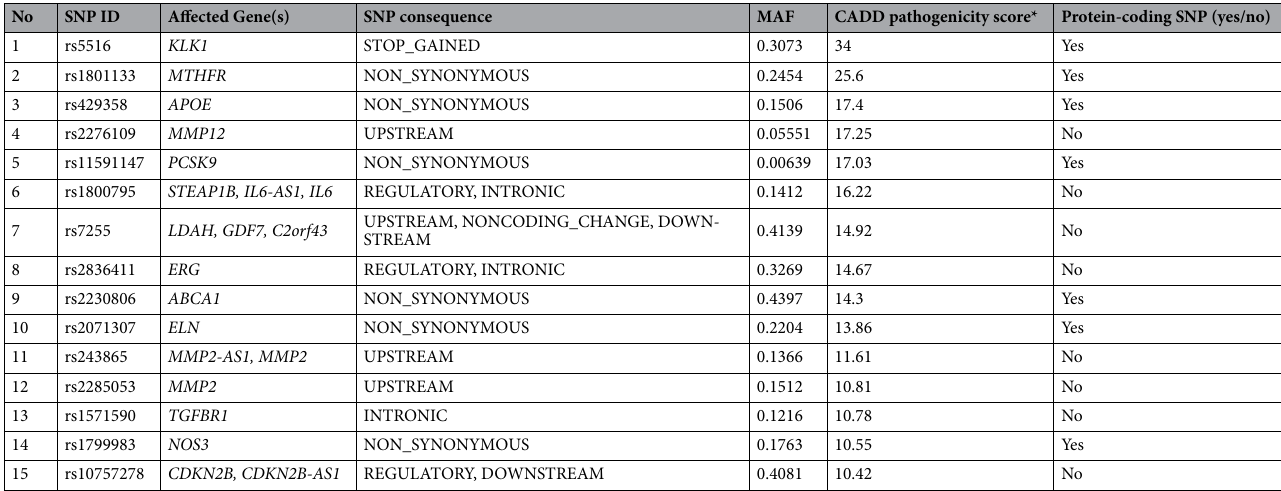
Table 1. The list of SNPs with high CADD (combined annotation dependent depletion) pathogenicity score. Higher CADD scores correlate to the deleterious effect of the nucleotide substitution, compared to all possible substitutions within the human genome. KLK1, Kallikrein 1; MTHFR, Methylenetetrahydrofolate Reductase; APOE, Apolipoprotein E; MMP12, Matrix Metallopeptidase 12; PCSK9, Proprotein Convertase Subtilisin/ Kexin Type 9; STEAP1B, STEAP Family Member 1B; IL6-AS1, IL6 Antisense RNA 1; IL6, Interleukin 6; LDAH, Lipid Droplet Associated Hydrolase; GDF7, Growth Differentiation Factor 7; ERG, ETS